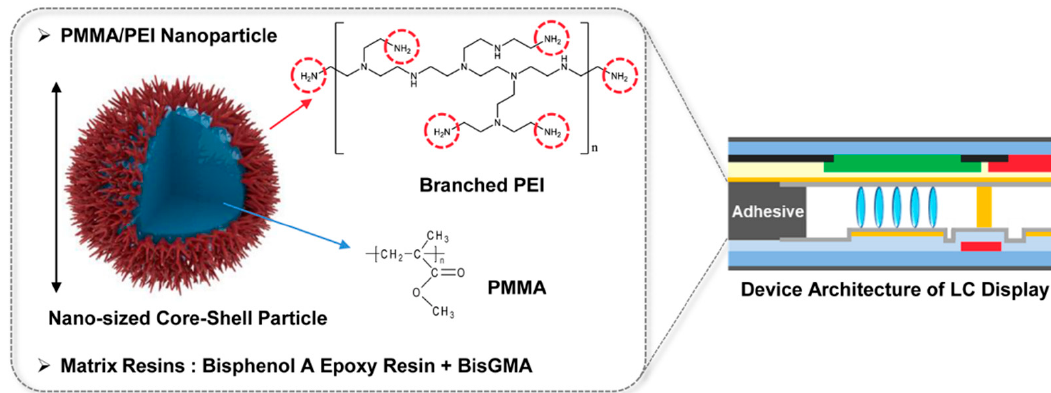
Figure 1. Schematic diagram of UV/heat dual-curable adhesive embedded with reactive core-shell polymer nanoparticles for super-narrow bezel display.